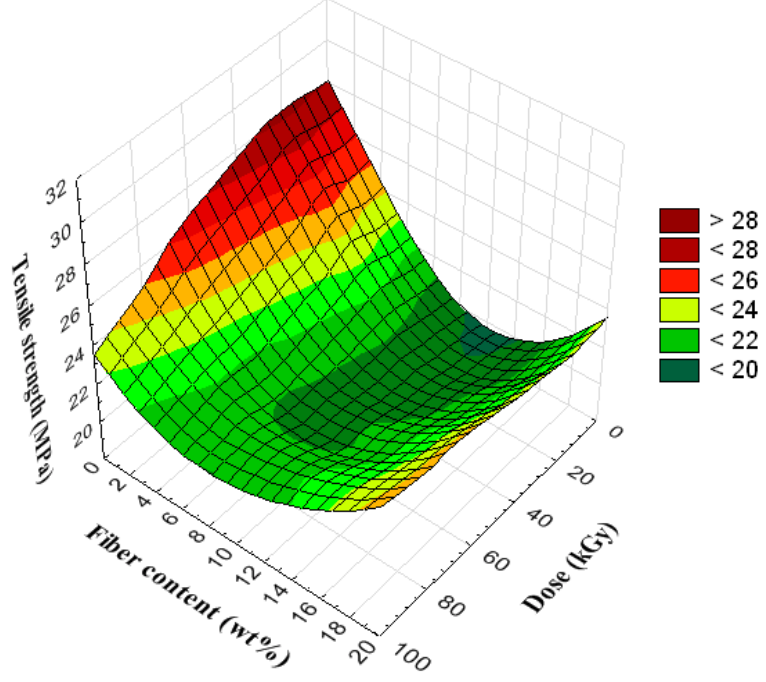
Figure 4. Tensile strength results.